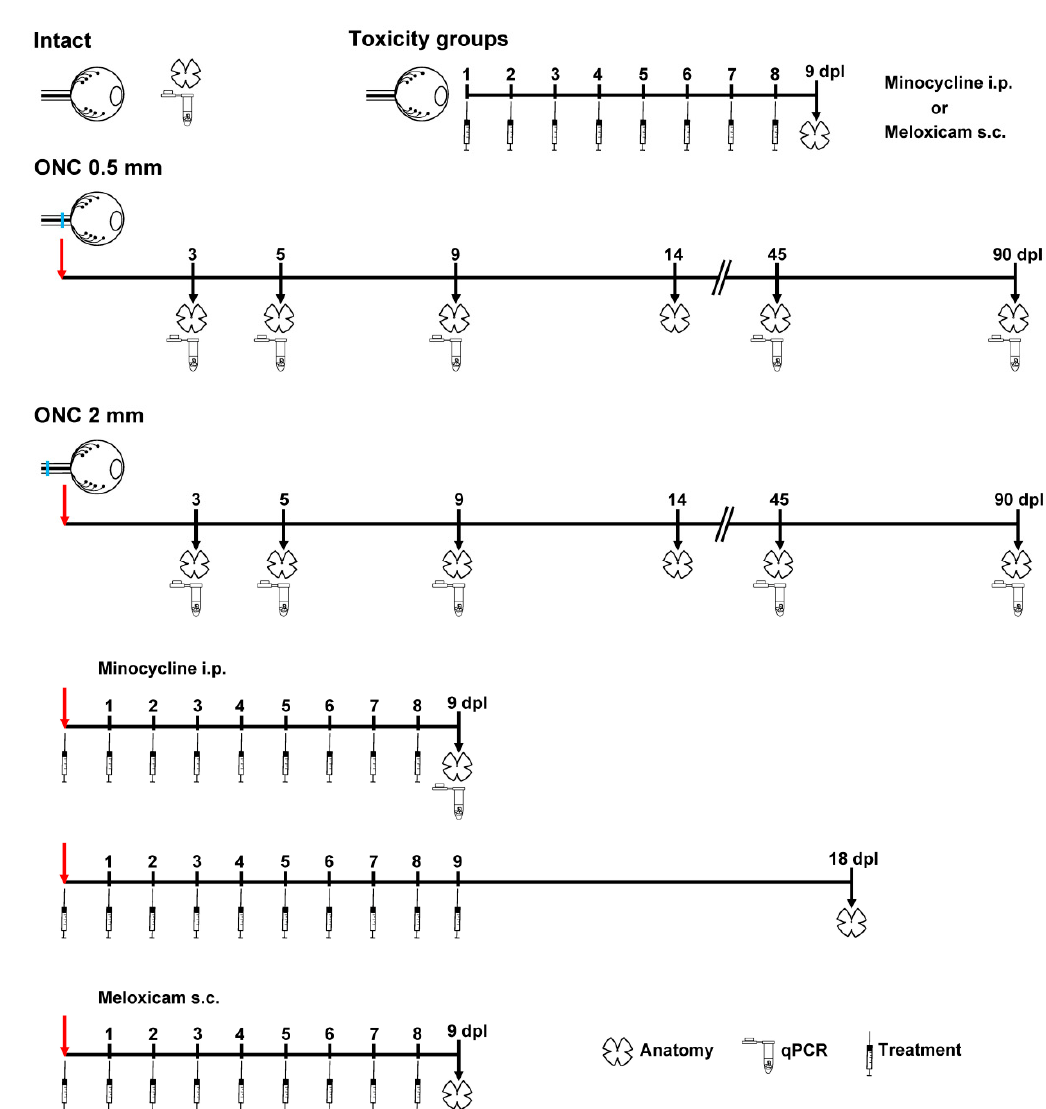
Figure 9. Experimental design: animal groups, timeline, and analyses. Toxicity analyses were done on animals that did not undergo optic nerve lesion. Both retinas of each animal were analyzed except for the ONC + meloxicam group at 18 days of which only the contralateral retinas were studied. Red arrows mark the surgery and black arrows the days of analyses. Retinal outlines indicate anatomical analyses: RGC quantification in all groups, and microglial morphology in intact, ONC 2 mm, and ONC 2 mm + minocycline at 9 dpl. Microtubes mean qPCR. Syringes mark the intraperitoneal (i.p.) or subcutaneous (s.c.) treatment with minocycline or meloxicam, respectively. The number of retinas analyzed per group, time point, and technique ranged from 4 to 10 (more details in figure legends). dpl: days post-lesion.